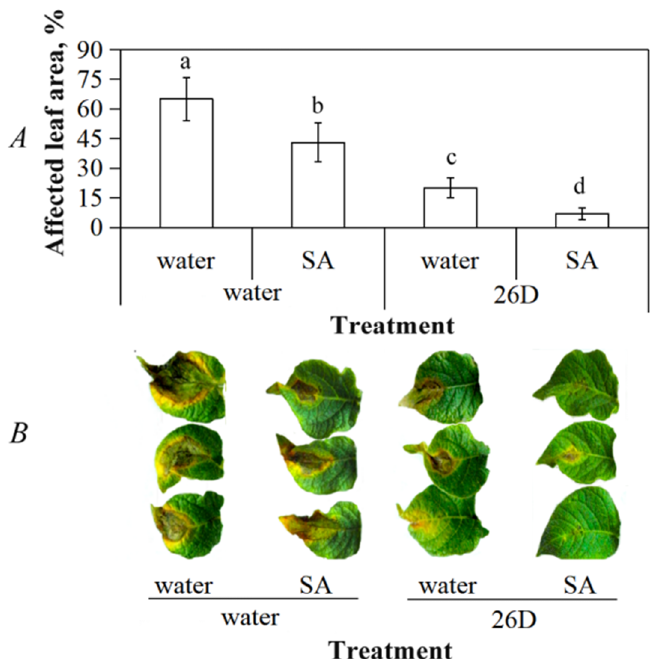
Figure 3. Impact of SA and B. subtilis 26D on development of late blight disease symptoms on potato leaves on the 12th day after P. infestans inoculation. ( A ) Percentage of leaf area with disease symptoms. ( B ) Late blight lesions on potato leaves. Values followed by the same alphabet are not significantly different from each other by Student test p < 0.05.